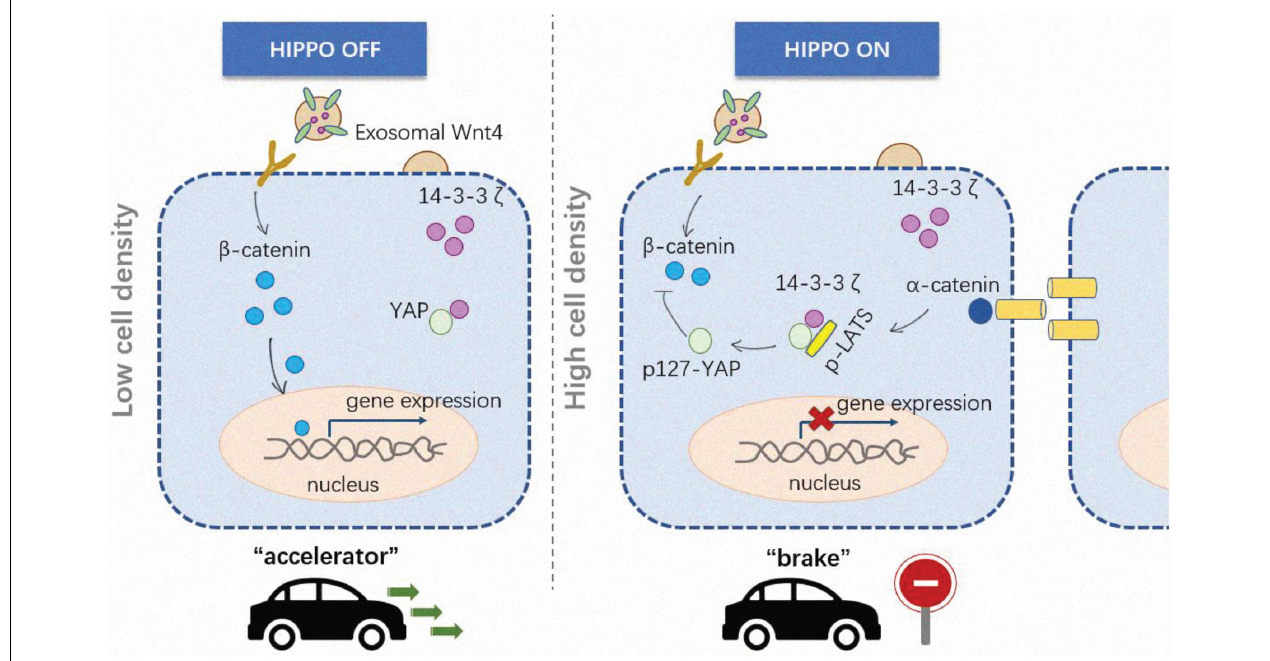
FIGURE 3 | The dynamically regulatory role of exosomes in burn injury. In the early stage of repairing, cells are in a low density, exosomal Wnt4 activates β -catenin in skin cells to promote proliferation and migration, meanwhile stimulates vascular endothelial cell to enhance angiogenesis. With the progression of wound healing, cell density becomes from low to high, the cell-cell contact triggers the activation of Hippo signaling, leading to p-LATS accumulation. 14-3-4 ζ released by exosomes works like a “table” to facilitate the combination of YAP and LATS, so as to accelerate the phosphorylation of YAP, the phosphorylated YAP shows a intracellular retention rather than nuclear translocation to suppress the down-stream gene expression and finally inhibit the cell proliferation and migration. The exosomes mediated dynamic regulation in different stage of wound healing, works as an “accelerate” to promote wound healing in early stage, while as a “brake” to prevent excessive proliferation and scar